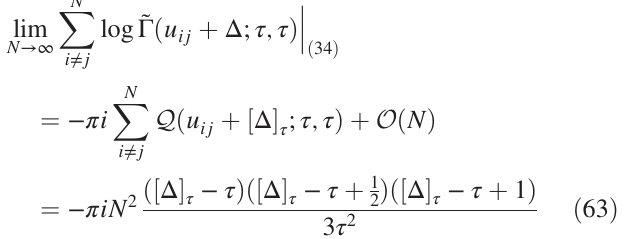
FIG. 1. In yellow is highlighted the domain, Eq. (56), in the complex Δ plane. The right boundary is the line γ , passing through 0 and τ . The left boundary is the line γ − 1 , passing through − 1 and τ − 1 . The dashed lines are other elements of γ þ Z